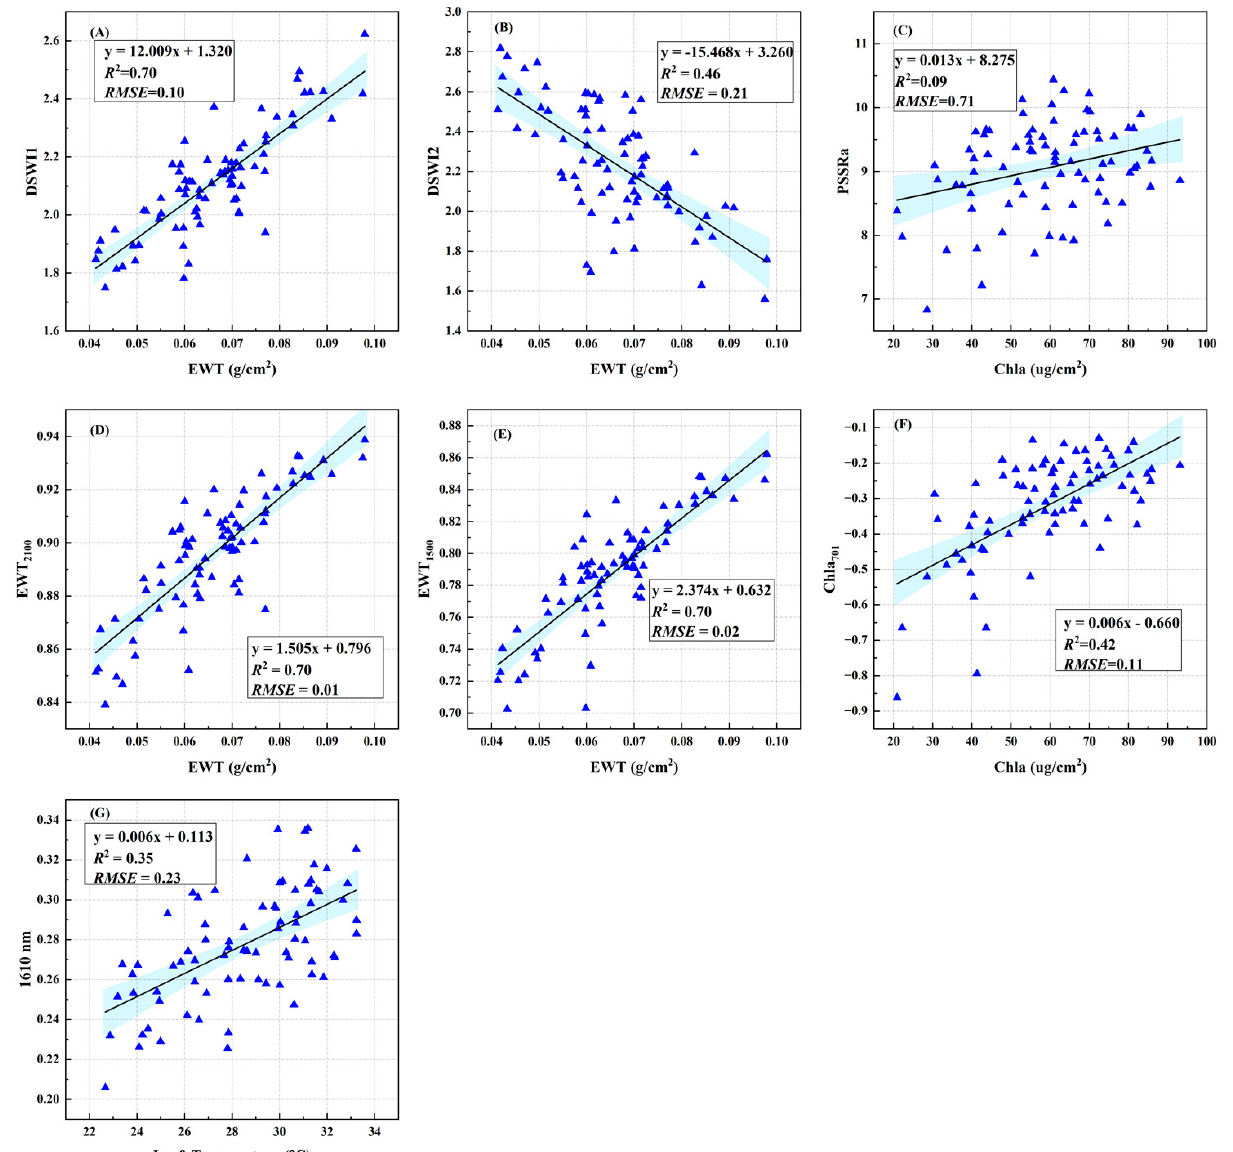
Figure 8. Quantitative relationship between the physiological characteristics of cotton verticillium wilt under early stress based on spectra. ( A , B , D , E ) represent the quantitative relationships between spectral indices DSWI1, DSWI2, EWT2100, EWT1500, and equivalent water thickness (EWT); ( C,F ) represent the quantitative relationships between PSSRa, Chla701, and chlorophyll a (Chla); ( G ) represent the quantitative relationship between the reflectivity with a spectral wavelength of 1610 nm and the leaf temperature. The blue-shaded area represents the 95% confidence interval of fitting.